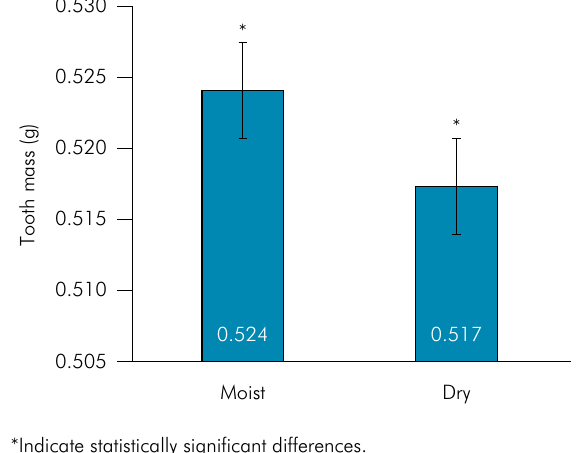
Figure 3. Mean and standard error of mass variation of moisture